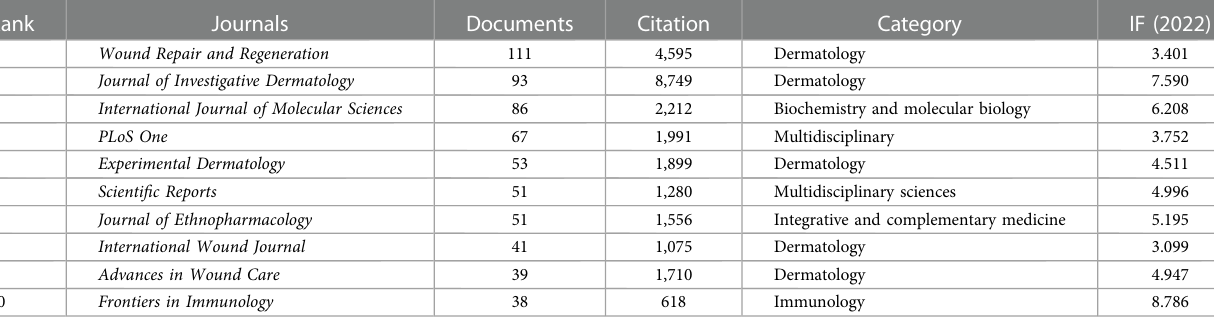
TABLE 2 The top 10 journals for